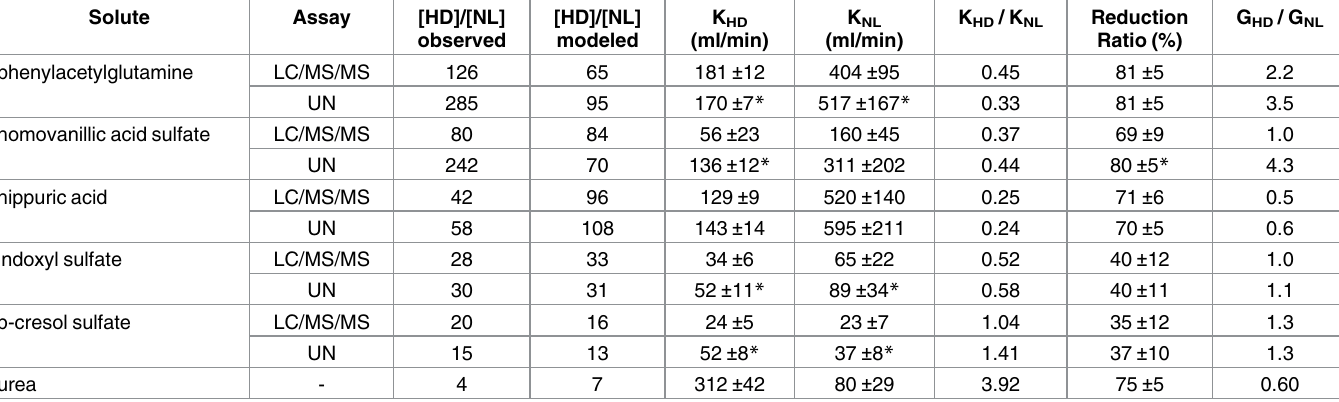
Table 2. Results of quantitative compared to untargeted mass spectrometric analysis.